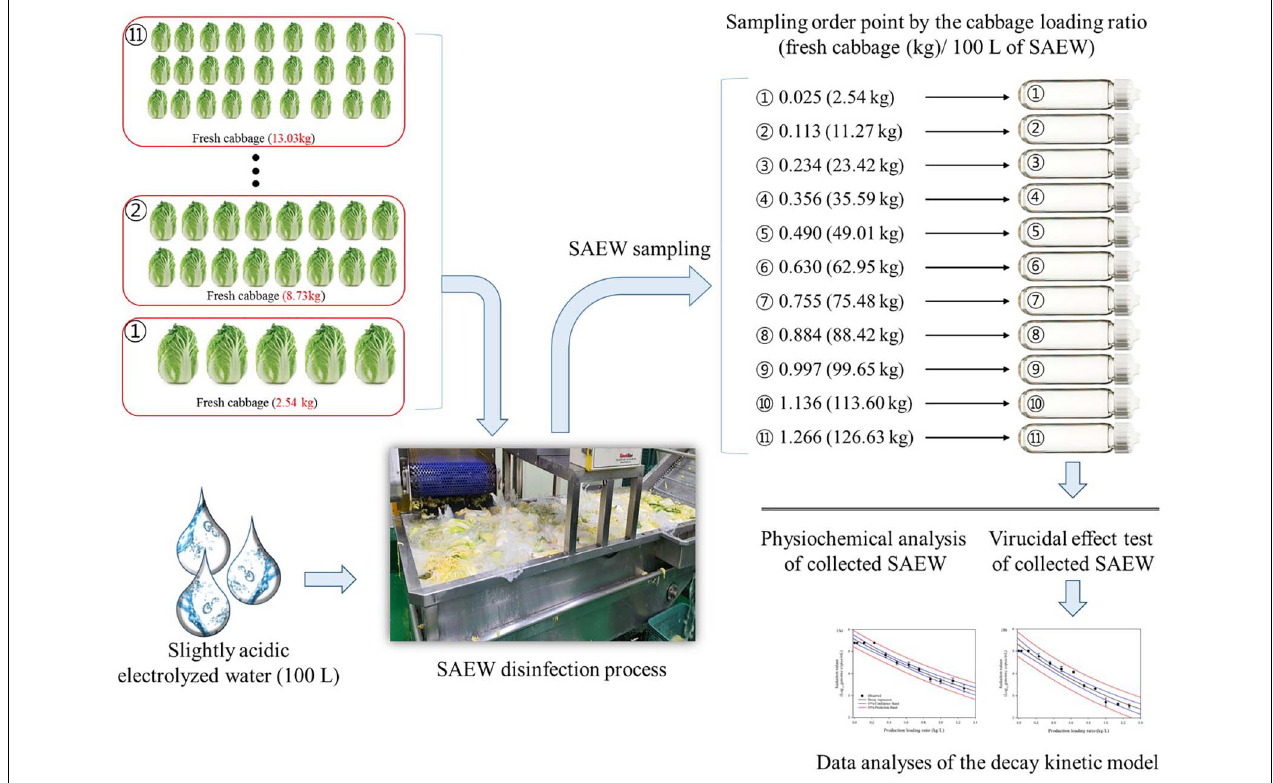
FIGURE 1 | Schematic diagram of the SAEW sampling for virucidal test of